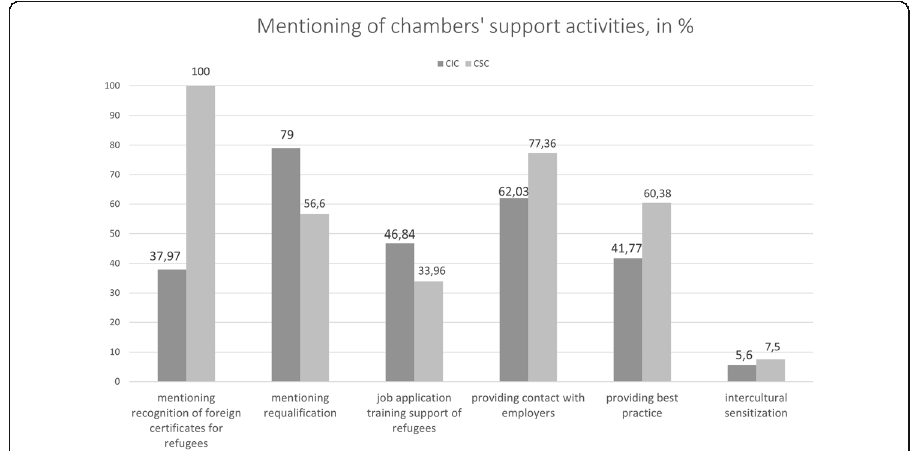
Fig. 1 Differences in refugee labour market inclusion support between the two chamber types. Source: own elaboration based on homepage analysis